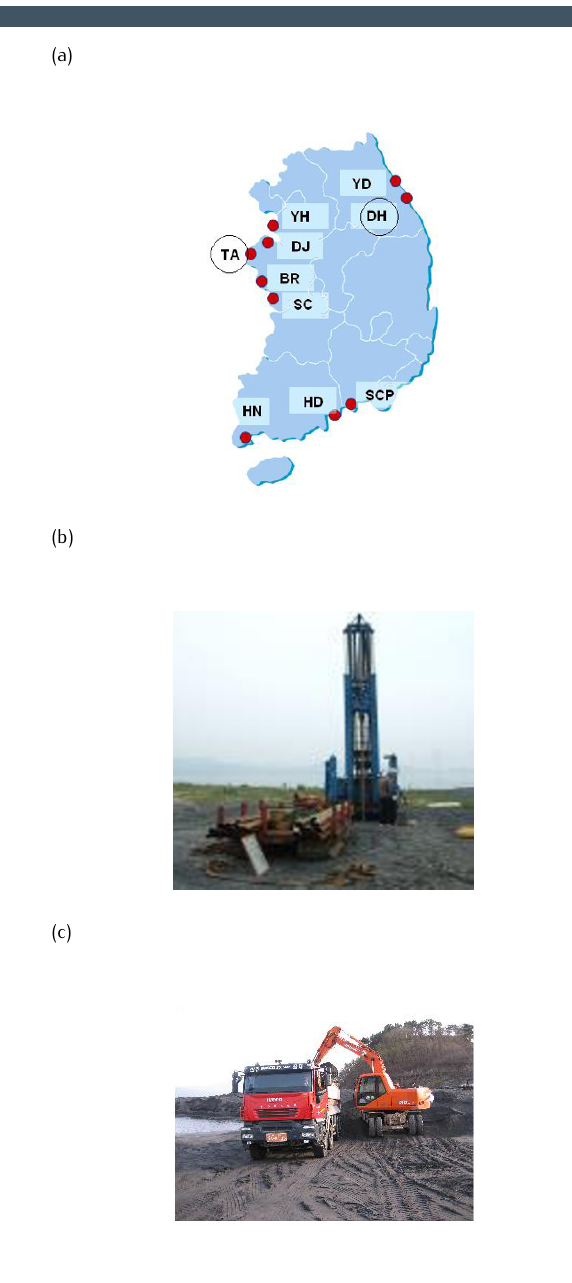
Figure 1. Sampling location and PA from site.